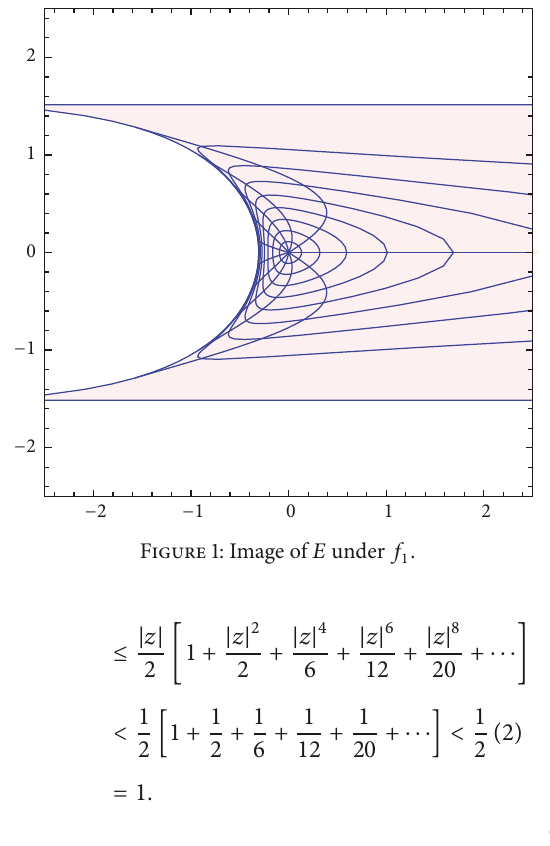
Figure 1: Image of 𝐸 under 𝑓 1